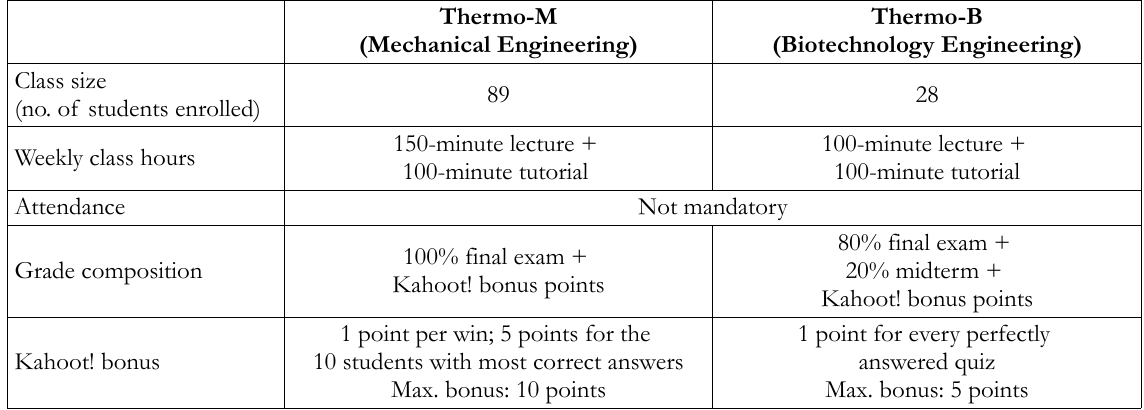
Table 1. Summary of the courses’ main characteristics and